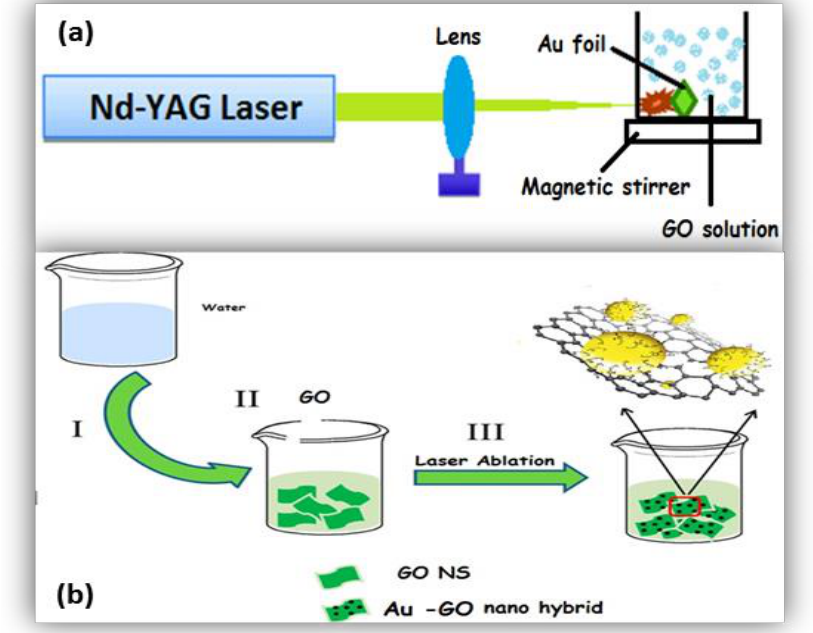
Figure 1. ( a ) The experimental framework of fabrication of Au-GO nano-hybrid; ( b ) synthesis procedure for the Au-GO